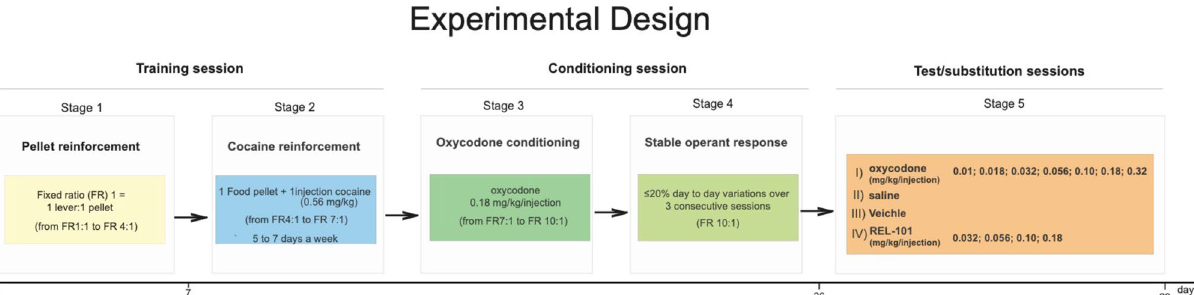
Figure 1. Self-administration study design (Study 1). The drawing illustrates Study 1 experimental protocol. During the first 7 days, rats were trained to respond by foot pressing on a lever, located within an operant response chamber, to receive a single food pellet reinforcement (45 mg). In this initial training session, rats were trained to respond under a fixed ratio (FR) 1:1 (1 lever press = 1 pellet delivery) schedule of reinforcement. When rats consistently responded to food rewards, the response requirements were increased until rats consistently responded under an FR4 (4 lever presses = 1 pellet delivery) schedule of reinforcement (Stage 1). Then, rats were trained to respond on the lever to self-administer cocaine (0.56 mg/kg/injection) paired with the delivery of a single 45 mg food pellet/injection for 1 training session; thereafter, food was discontinued, and the rats continued with self-administration of cocaine only. The progressive establishment of cocaine as a reinforcer was obtained with a final FR7 (7 lever presses = 1 cocaine delivery) (Stage 2). At this point, the conditioning session started, the cocaine was replaced, and the rats were given access to 0.18 mg/kg/injection of oxycodone. During the oxycodone only training sessions, the response requirements were increased until rats achieved a FR10 (10 lever presses = 1 oxycodone injection) (Stage 3). Stable operant responding (Stage 4) was defined as responding under an FR10 schedule for oxycodone injections with ≤ 20% day to day variations consecutive sessions, lever pressing resulted in self-administration of saline or oxycodone at 0.01, 0.018, 0.032, 0.056, 0.10, 0.18, and 0.32 mg/kg/injection (Test Sessions), and REL 1017 at 0 (vehicle), 0.032, 0.056, 0.10, and 0.18 mg/kg/injection (Substitution